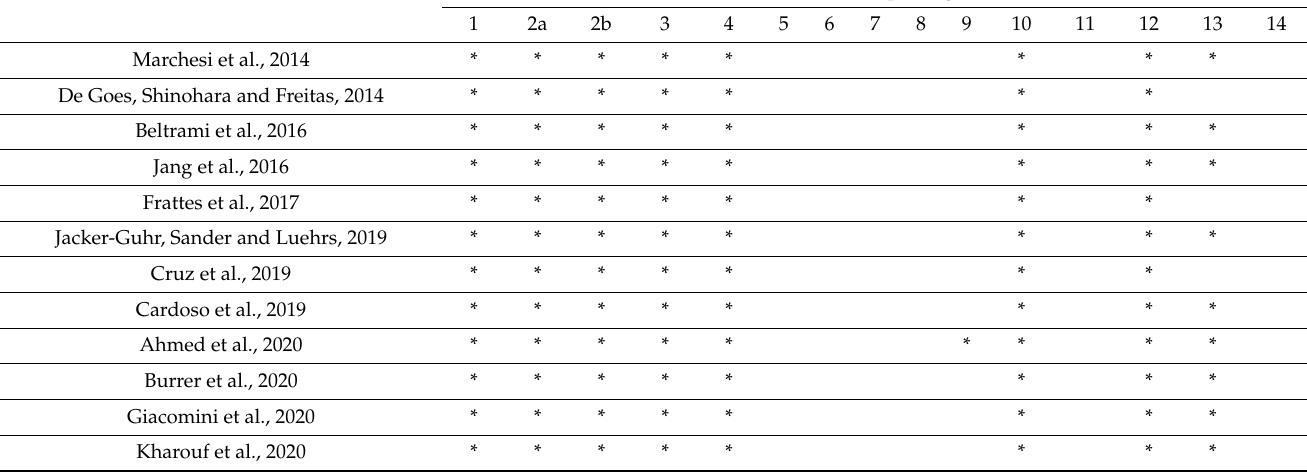
Table 3. Results of the assessment of in vitro studies [12–23] by the use of the modified CONSORT checklist [11]. Cells marked with an asterisk “*” represent study fulfilment for the given quality assessment parameter. Cells left blank represent